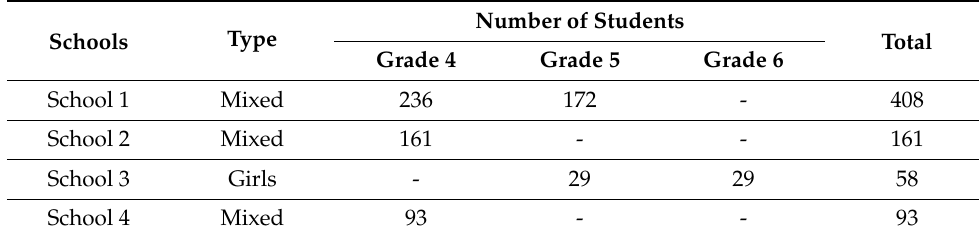
Table 2. Sample’s